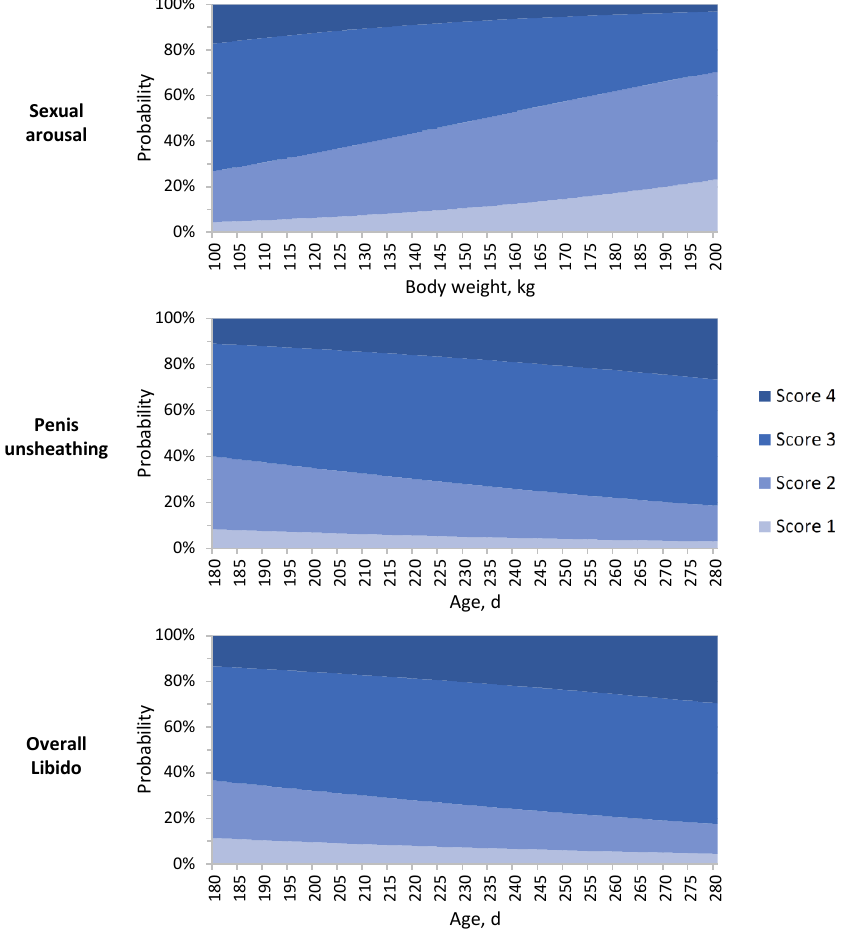
Figure 2. Probability of sexual arousal, penis unsheathing, and overall libido scores (1 = poor; 4 = good) at different body weight and